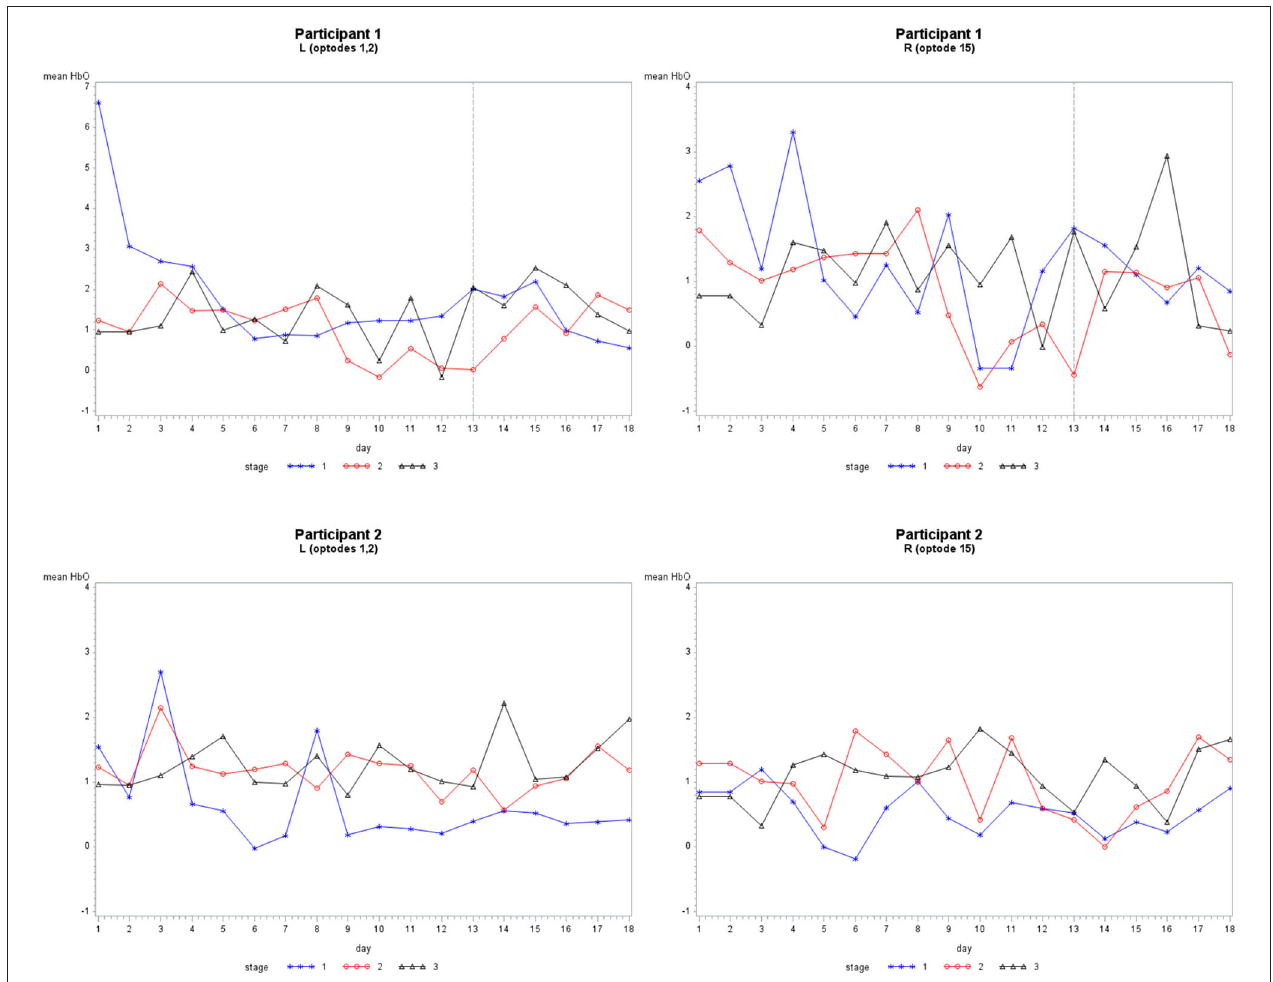
FIGURE 4 | The mean HbO activity for Grouping 1 by stage for each participant. The vertical line at day 13 for participant 1 indicates set 1 to the left and set 2 to the